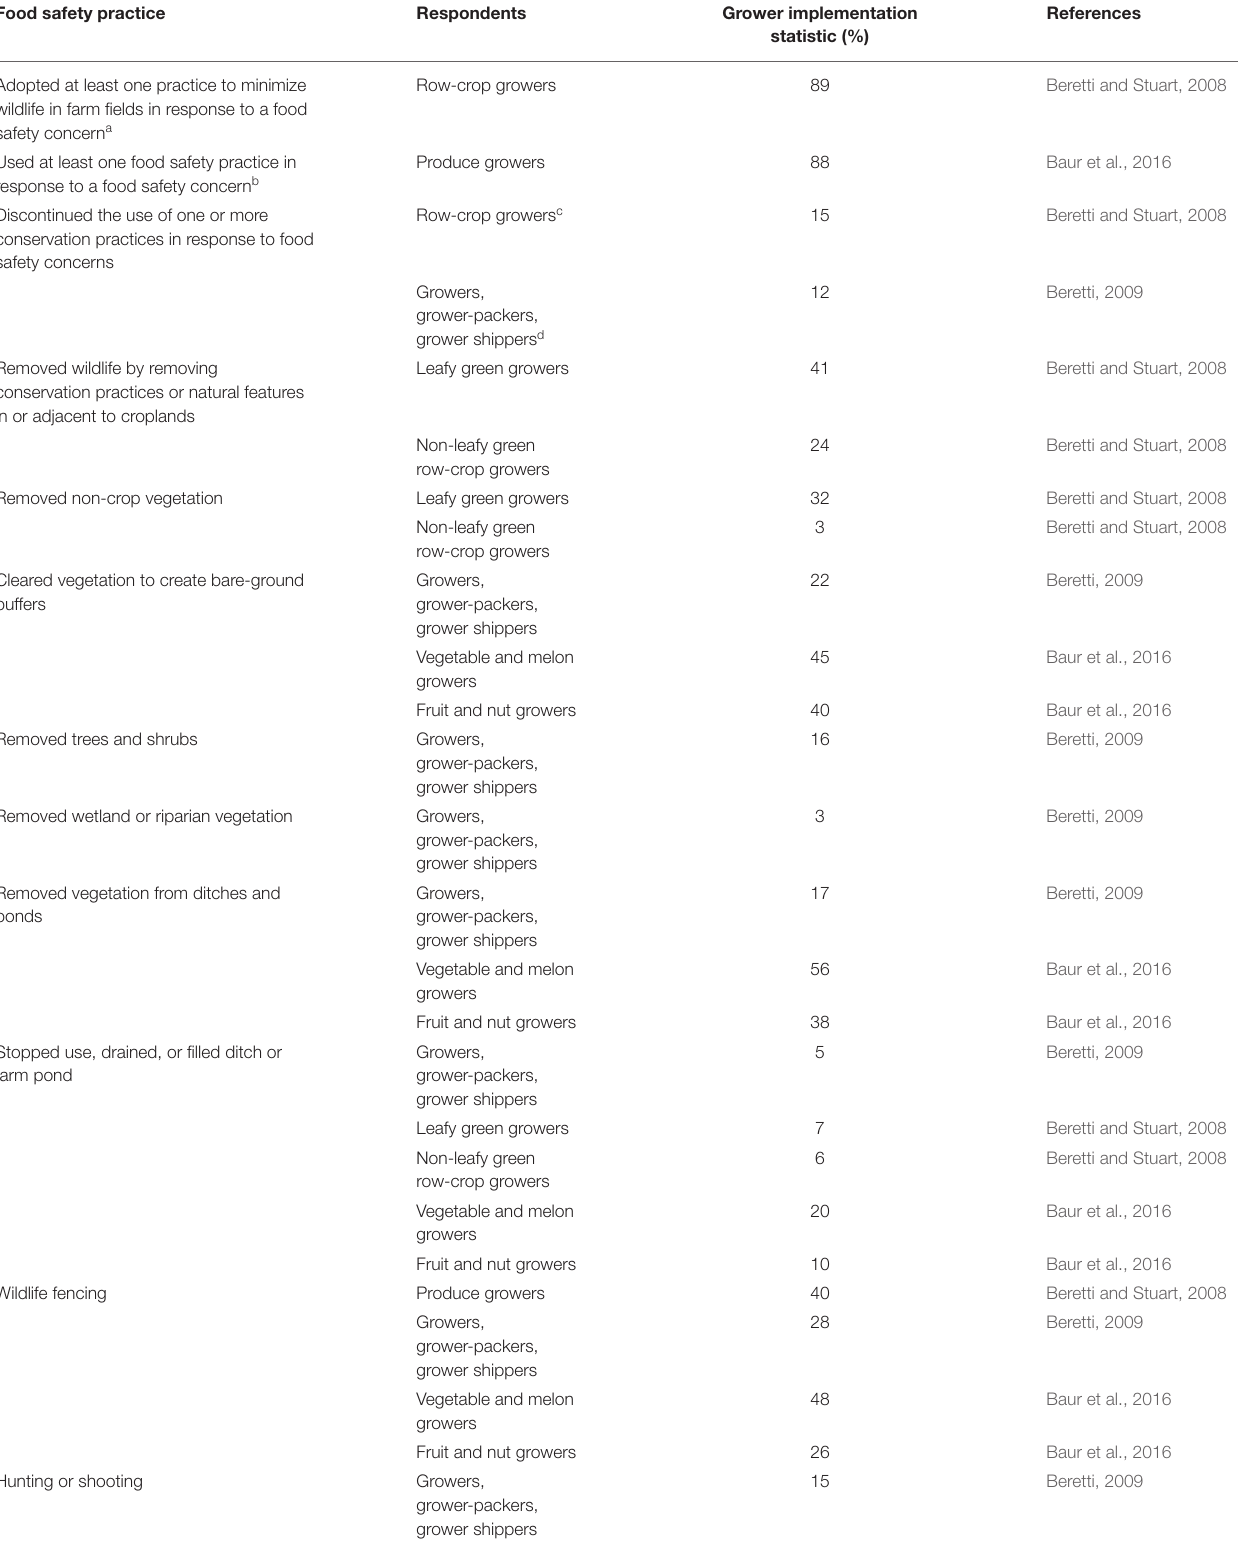
TABLE 2 | Grower adoption of food safety practices and abandonment of conservation practices in response to food safety